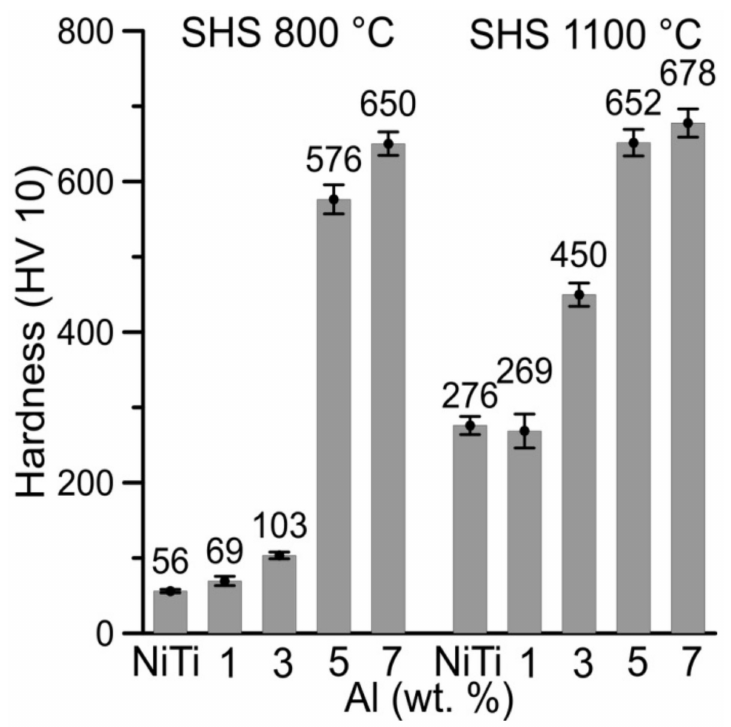
Figure 11. Hardness of samples sintered at 800 and 1100 ◦ C.